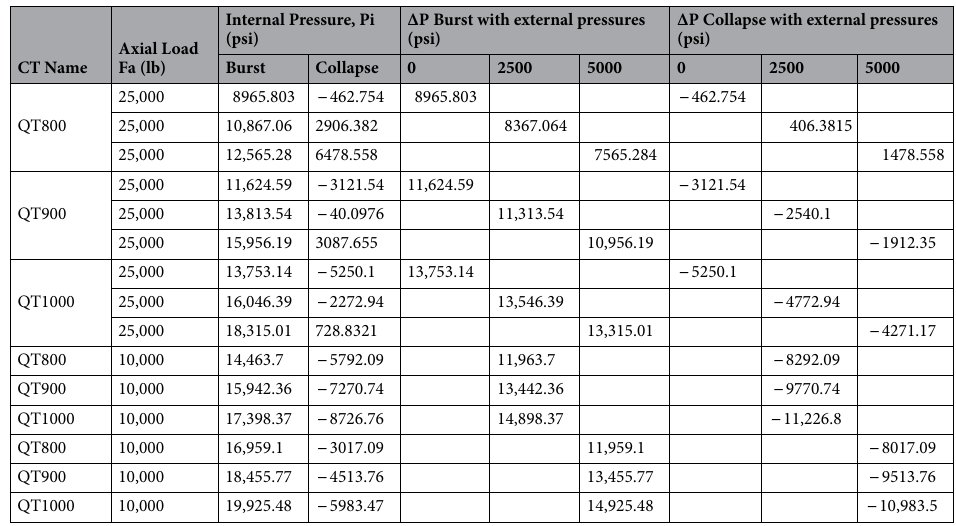
Table 5. Comparison of Limit curve data for different external pressures, P o